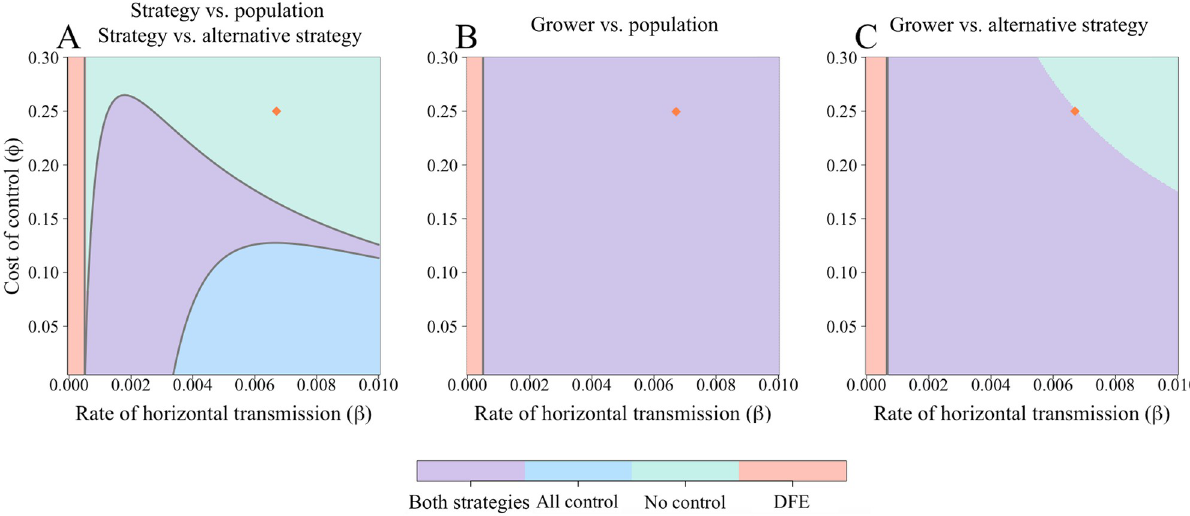
Fig 2. Effect of the rate of horizontal transmission ( β ) and the cost of control ( ϕ ) on final equilibrium attained. A The “strategy vs. population” and “strategy vs. alternative” models have four possible, mutually-exclusive equilibria. For any given parameter set, both of these models will have the same equilibrium values. Which is attained depends both on R 0 and the balance of benefit between controlling and not controlling. Below R 0 = 1 (which corresponds to the vertical line at β = 0.0005 day − 1 ), only the disease-free equilibrium (DFE) is possible. Boundaries between equilibria are determined by the stability conditions (S3 Text). Also shown in B and C are the equilibria for the “grower vs.” models, though numerical expressions determining these cannot be derived analytically. Parameters are as in Table 1; the orange diamonds mark the default values β and ϕ (which, in C, is in the “no control” region). The dynamics for these default values are shown in Fig 3. B does not show all equilibria achievable for the “grower vs. population” model (see Fig A in S3 Text).